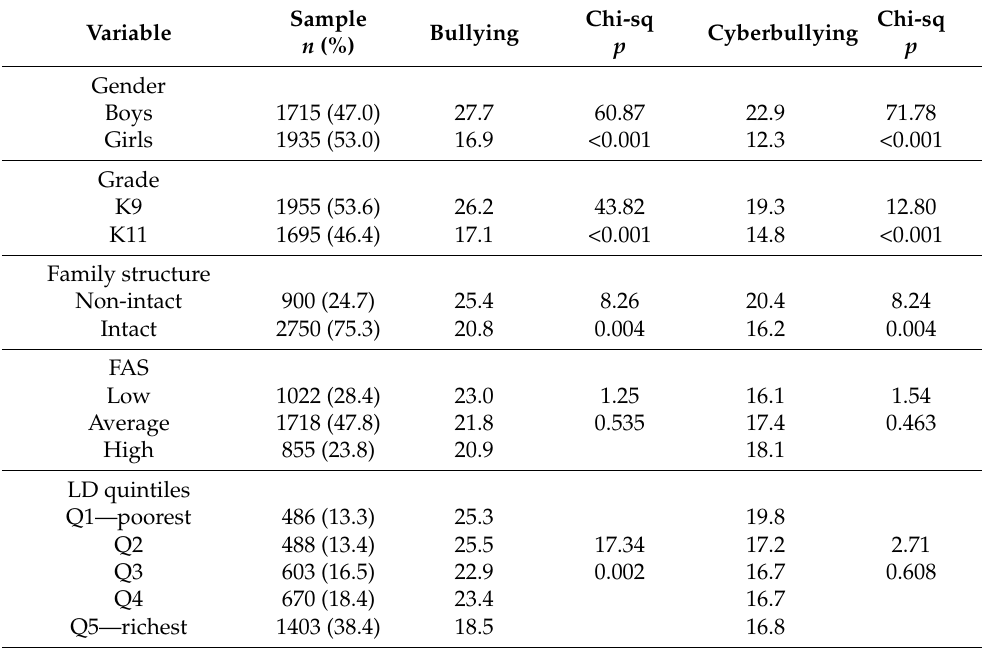
Table 1. Bullying and cyberbullying perpetration at least once in the past two months (%) according to demographic and socioeconomic factors.